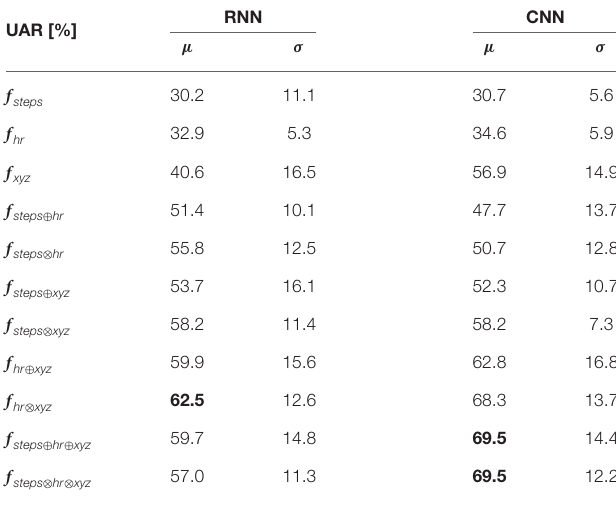
TABLE 3 | Summary of the descriptive statistics ( µ : mean, σ : standard deviation) computed from the UAR scores obtained when assessing the unimodal and the multimodal standard HAR-based end-to-end models using nested